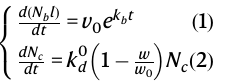
Fig. 1 | PDAC cells cultured in fl oating collagen gels give rise to branched organoids. a From left to right, dashed boxes outline inset region: Day 13 PDAC organoid in Matrigel staining (blue: DAPI, white: F-actin, n =3 individual experi- ments),Day 13 PDAC organoid incollagen staining (blue: DAPI, white: F-actin, n =3 individual experiments), E- and N- cadherin staining of a Day 13 PDAC organoid in collagen (green: E-cadherin, red: N-cadherin, blue: DAPI, n =3 individual experi- ments), 3D reconstruction of a Day 13 PDAC organoid staining in collagen (blue: DAPI,red:Cytokeratin-7, n =3individualexperiments).Scalebarsfromlefttoright: 200 µ m top and 50 µ m bottom, 200 µ m top and 50 µ m bottom, 100 µ m, 200 µ m. b Bright fi eld snapshots of collagen- (top, n =71 organoids) and Matrigel-grown organoids(bottom, n =54 organoids) atvarious time points.Colored bars in b and c indicate the current development phase of collagen-grown organoids: Onset (blue),Extension(orange),Thickening(green),andLumenFormationphase(pink). Scale bars, top from left to right: 200 µ m for the fi rst two pictures, 500 µ m for the rest;bottom:100 µ m. c Majoraxislengthevolutionovertimeofindividualcollagen-